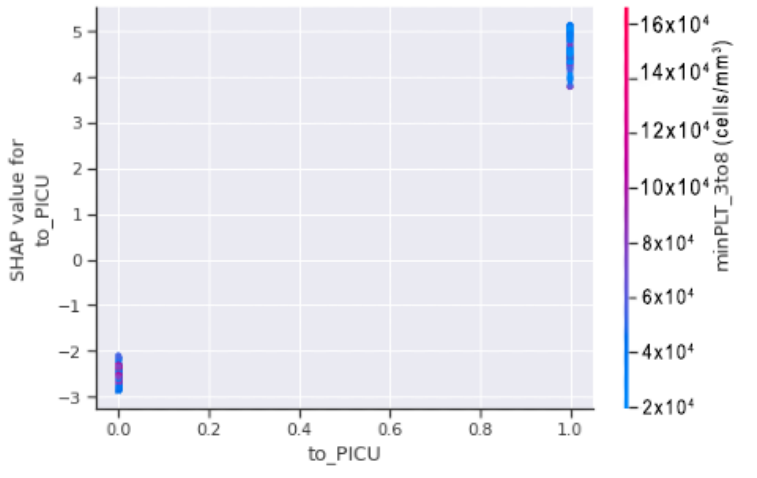
Figure 15. SHAP dependence plot of minPLT_3to8 and to_PICU illustrating to_PICU along horizontal axis and minPLT_3to8 along vertical